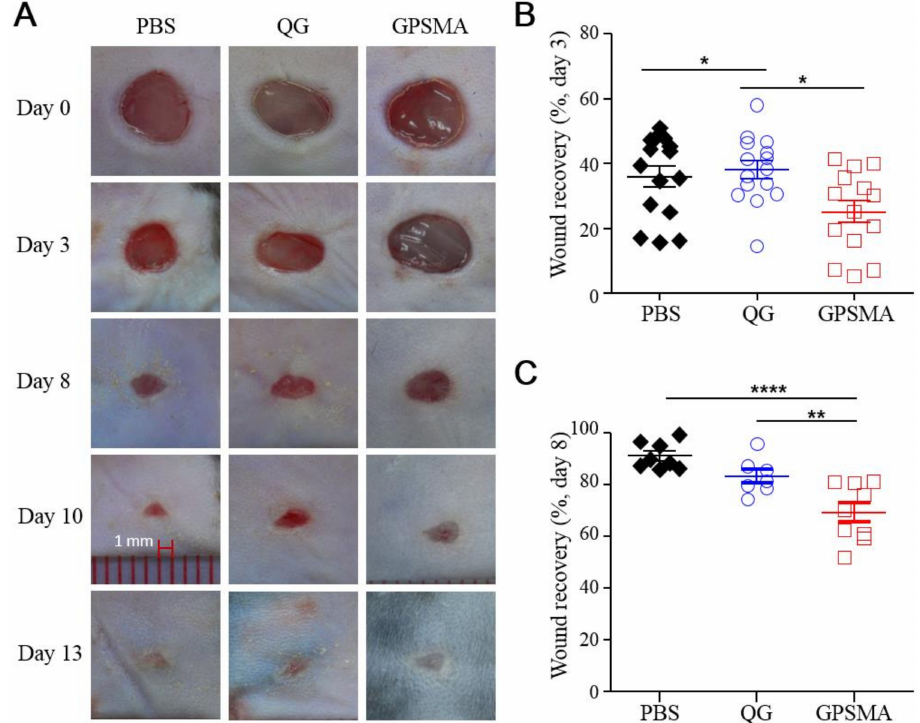
Figure 6. In vivo wound healing e ff ects. ( A ) Representative digital images of wounds; ( B ) and ( C ) quantitative evaluation results of wound closure on the dorsal skin of mice treated with phosphate-bu ff ered saline (PBS), QG, and GPSMA. Data are reported as the mean ± SD; * indicates a significant di ff erence between samples (* p < 0.05; ** p < 0.01; **** p < 0.0001) using a one-way ANOVA with Tukey’s multiple comparisons